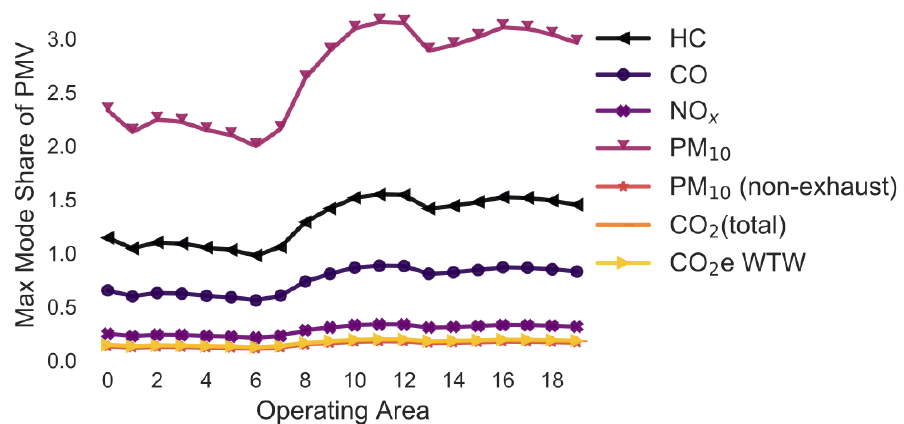
Figure 7. Maximum share of customers who can pick up a parcel by car (varying vehicle fleet age) (note: CO 2 (total) and CO 2 e WTW are the same).